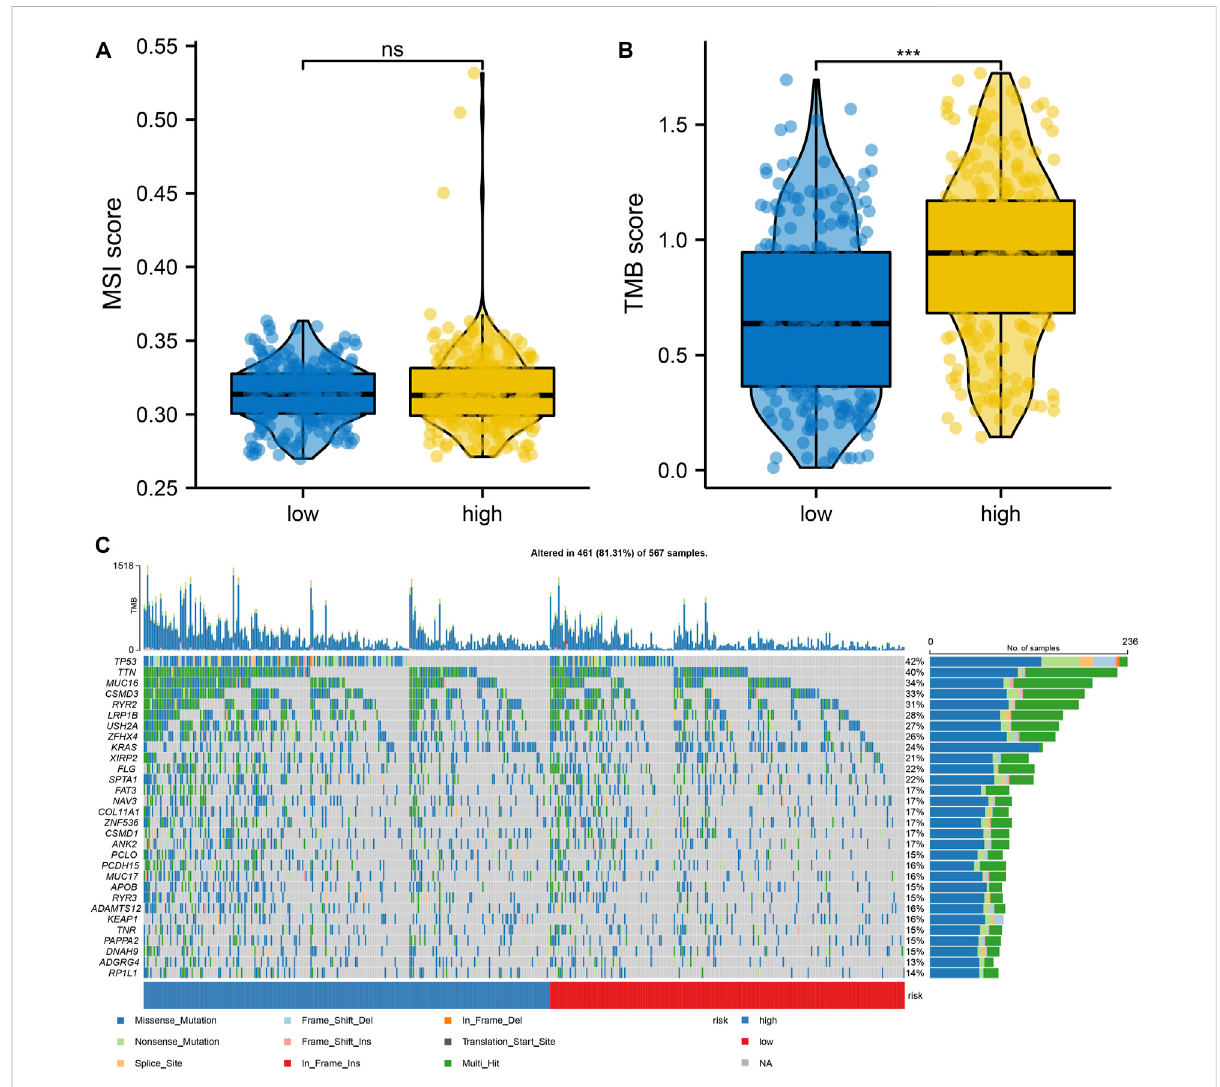
FIGURE 5 Differences in mutation signatures between high-and low-risk groups (A) Differences in MSI score between high- and low-risk groups (B) Differences in TMB score between high-and low-risk groups (C) Differences in the top 30 mutant genes between high-and low-risk groups. *represents p < 0.05; ** represents p < 0.01; *** represents p < 0.001; ns represents no signi fi cant difference ( p >